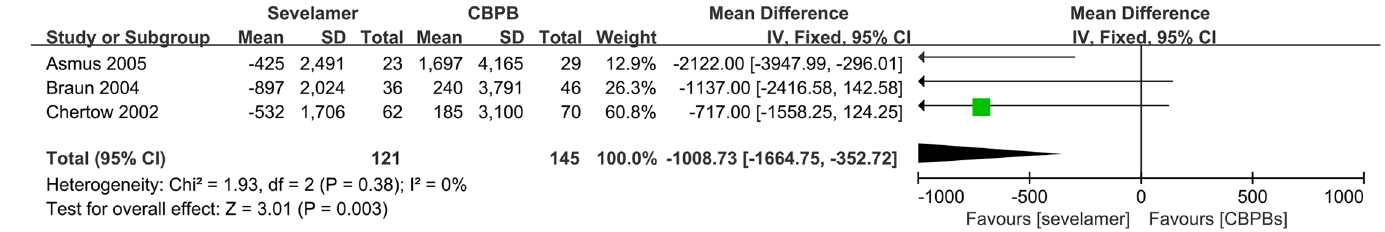
Fig 6. Forest plot of sevelamer vs. calcium phosphate binders on ACS change.